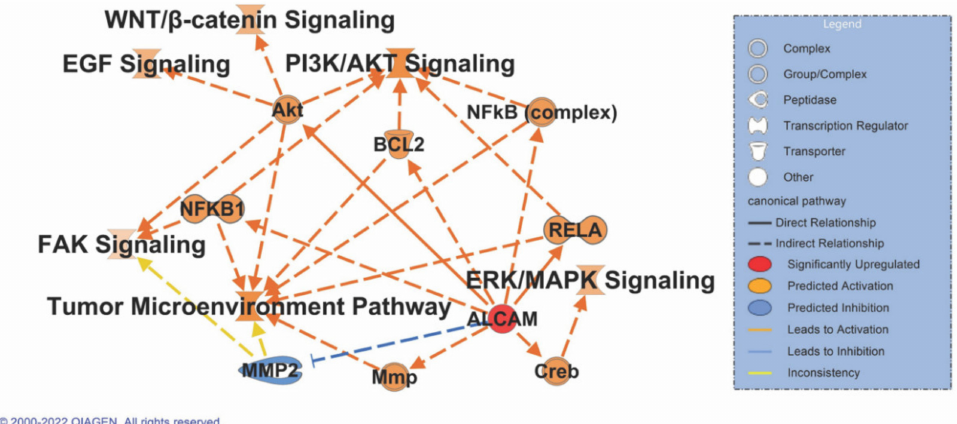
Figure 7. IPA path design with major signaling pathways specific to pancreatic cancer to be upregu- lated on activation of ALCAM. Solid lines indicate a direct association while dashed lines indicate indirect association with a signaling pathway. Orange denotes activation while blue indicates inhibi- tion, and yellow indicates inconsistent relationship or data points to predict the connection between the